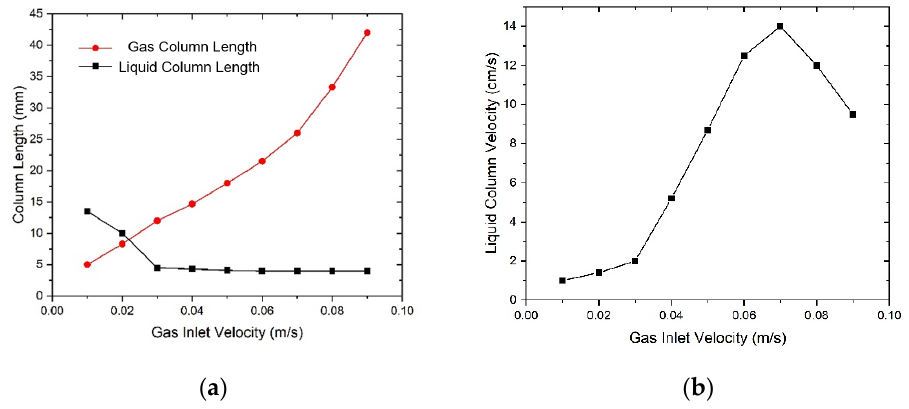
Figure 7. ( a ) Variation of gas and liquid column length with gas velocity conditions; ( b ) Variation of the average liquid column flow velocity with gas velocity conditions.